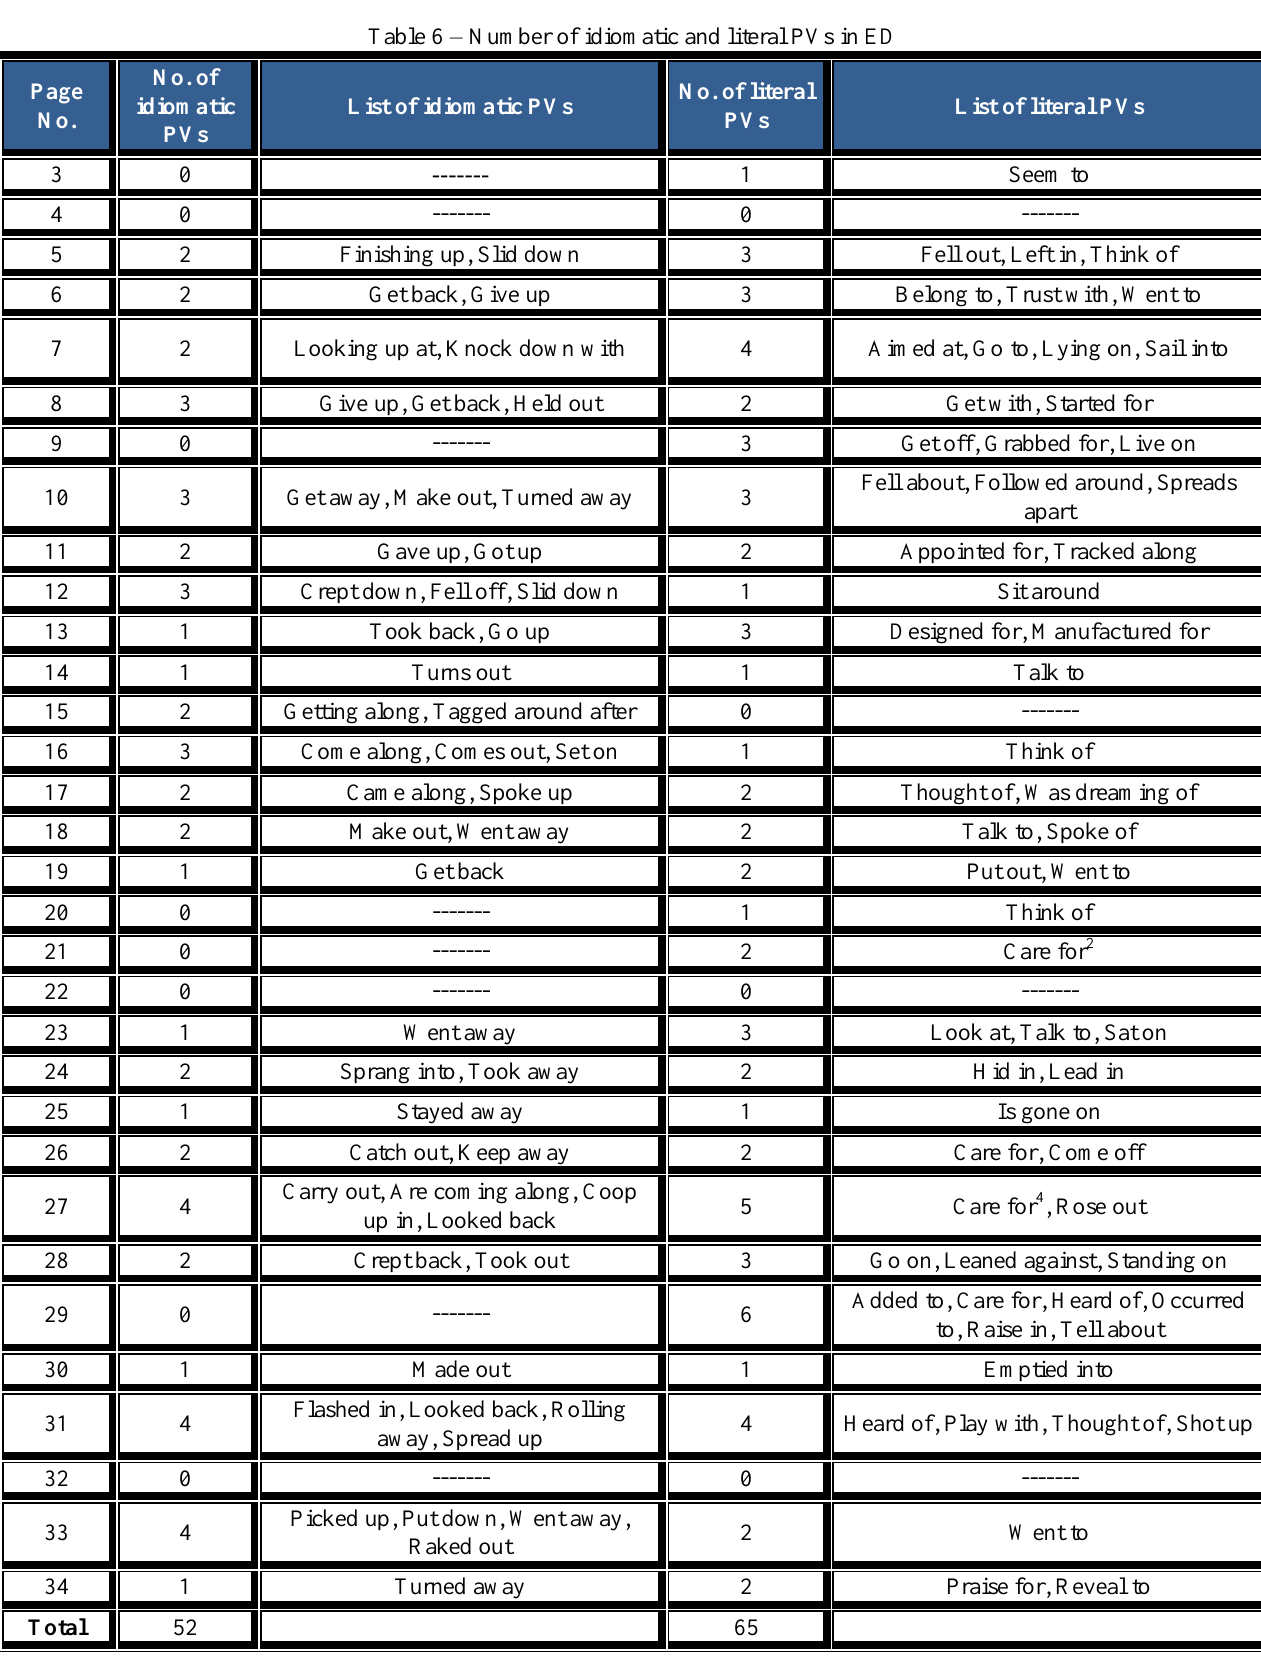
Table (6) concentrates on the number of idiomatic and literal PVs used in